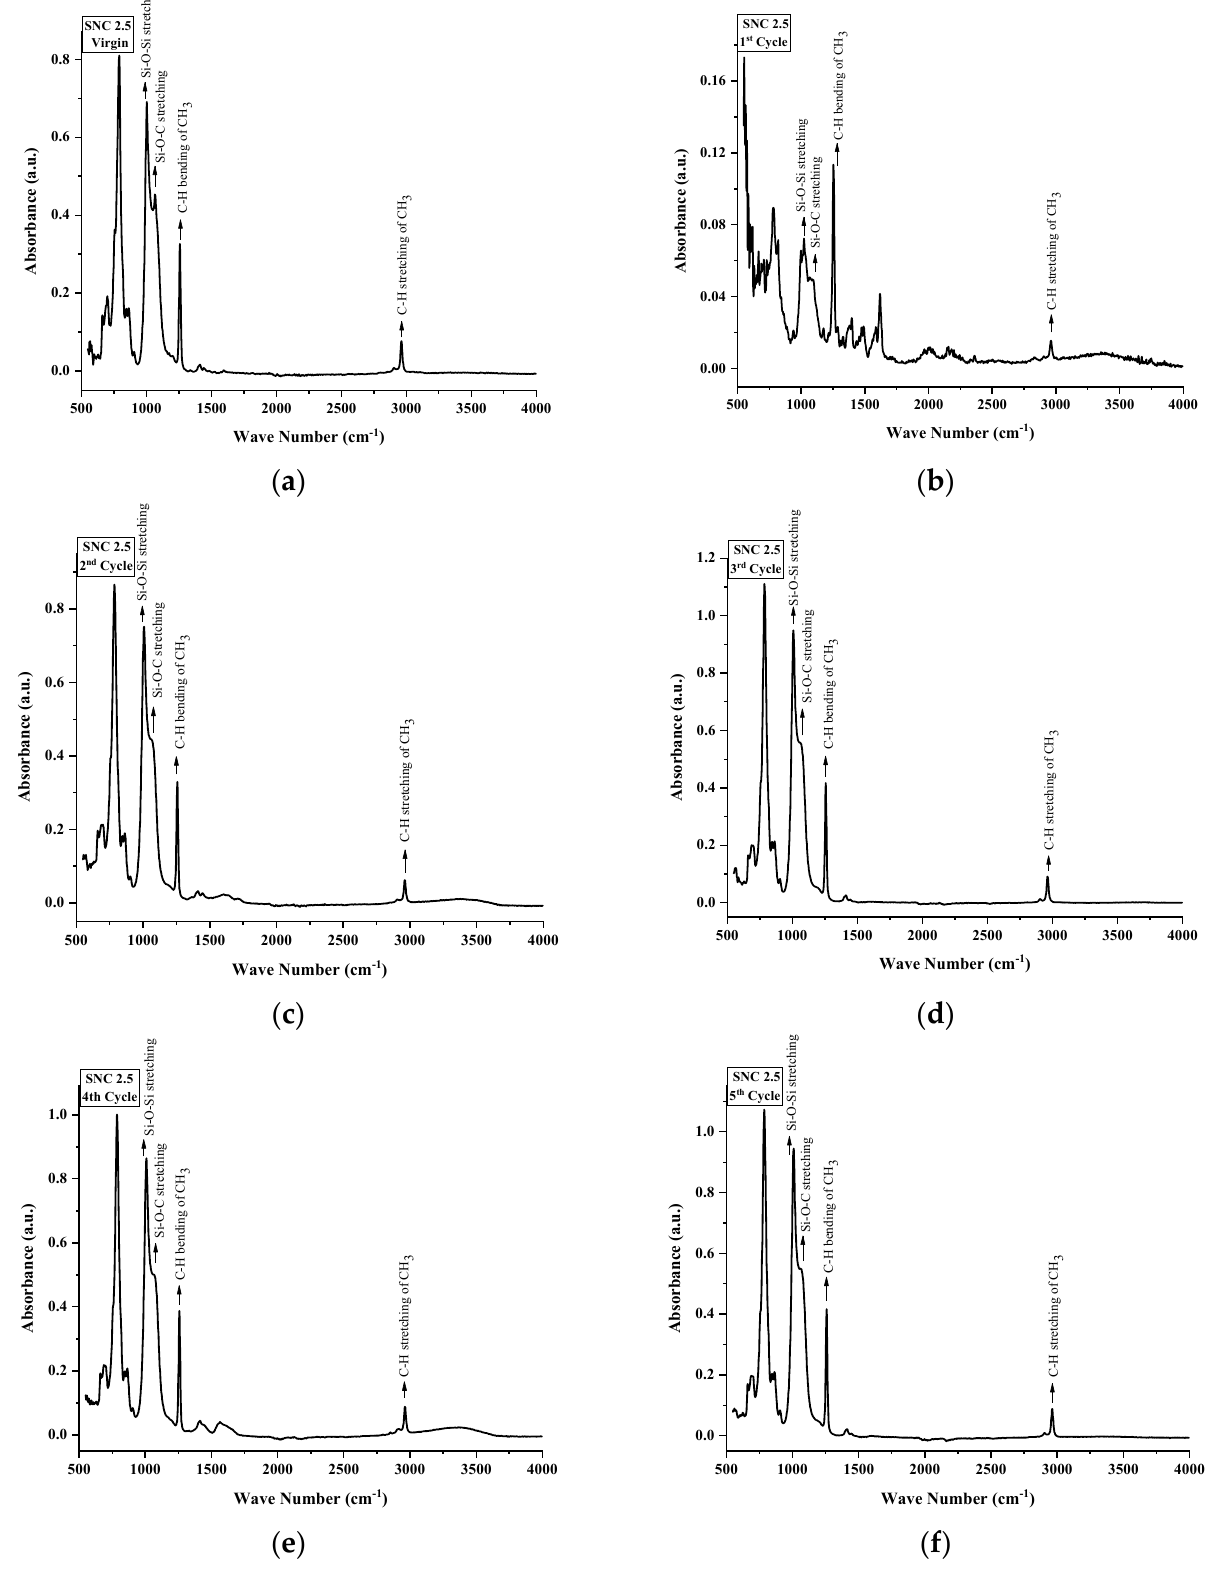
Figure 14. FTIR images of SNC 2.5: ( a ) virgin; ( b ) after 200 h. ( c ) after 400 h; ( d ) after 600 h; ( e ) after 800 h; ( f ) after 1000 h. Overlay plots for better comparison are given in Figure 16.